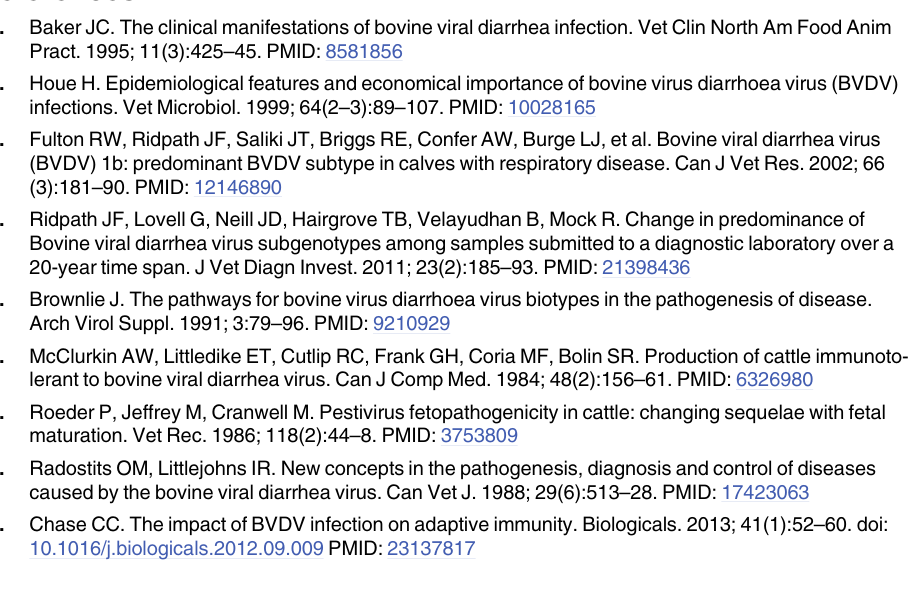
S4 Table. Befi-BaTS analysis of posterior sets of trees derived from gene alignments for each PI animal. Tree size and internal branch size are average measures of all trees in the set while the remaining parameters are measures of the association between tissue compartment and phylogenetic clustering. All measures of clustering have non-overlapping 95% confidence intervals relative to null distributions with the exception of UniFrac intervals, which do overlap in all cases. S5 Table. Position and frequency of E2 mutations in tissue-specific clusters. The first num- ber of the cluster name indicates the PI in which the cluster was identified. Compartmentalized variants were found in tissues of the obex and/or tonsil in four of ten PI cattle in this study. No mutations were shared among multiple PI hosts from different farms, although both PI 1 and 9 had mutations at position 170 in obex clusters (underlined). All mutations are denoted by the original nucleotide/amino acid, the genome position, and the new nucleotide/amino acid. All genome positions are relative to the NADL (GenBank# M31182) to allow for consistent num-